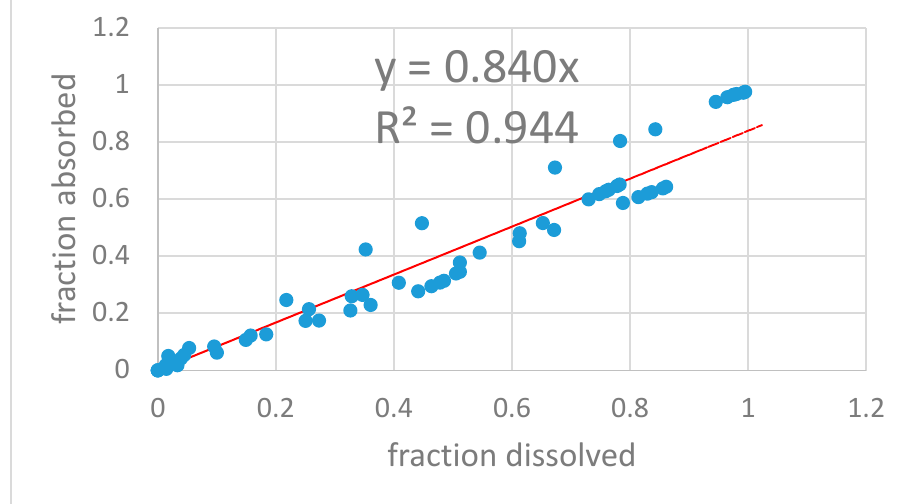
Figure 8. Two ‐ step level ‐ A two ‐ step IVIVC for the four montelukast products.